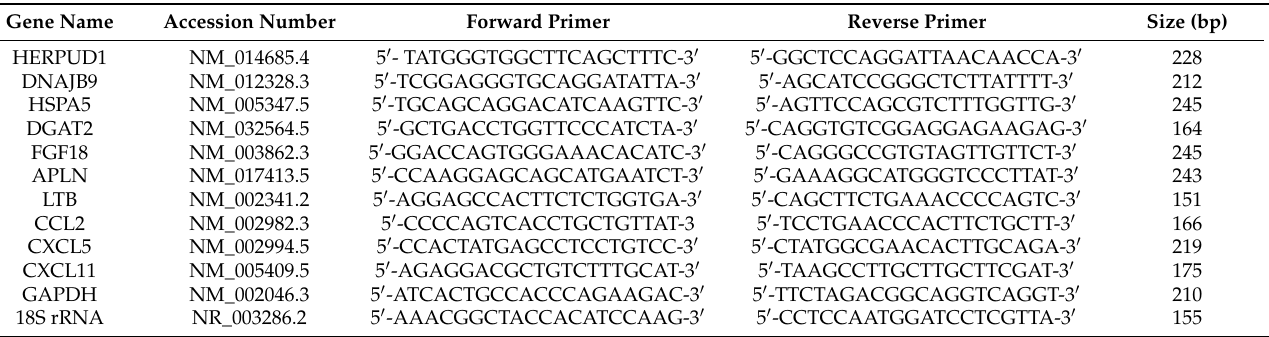
Table 1. Primers sequence for